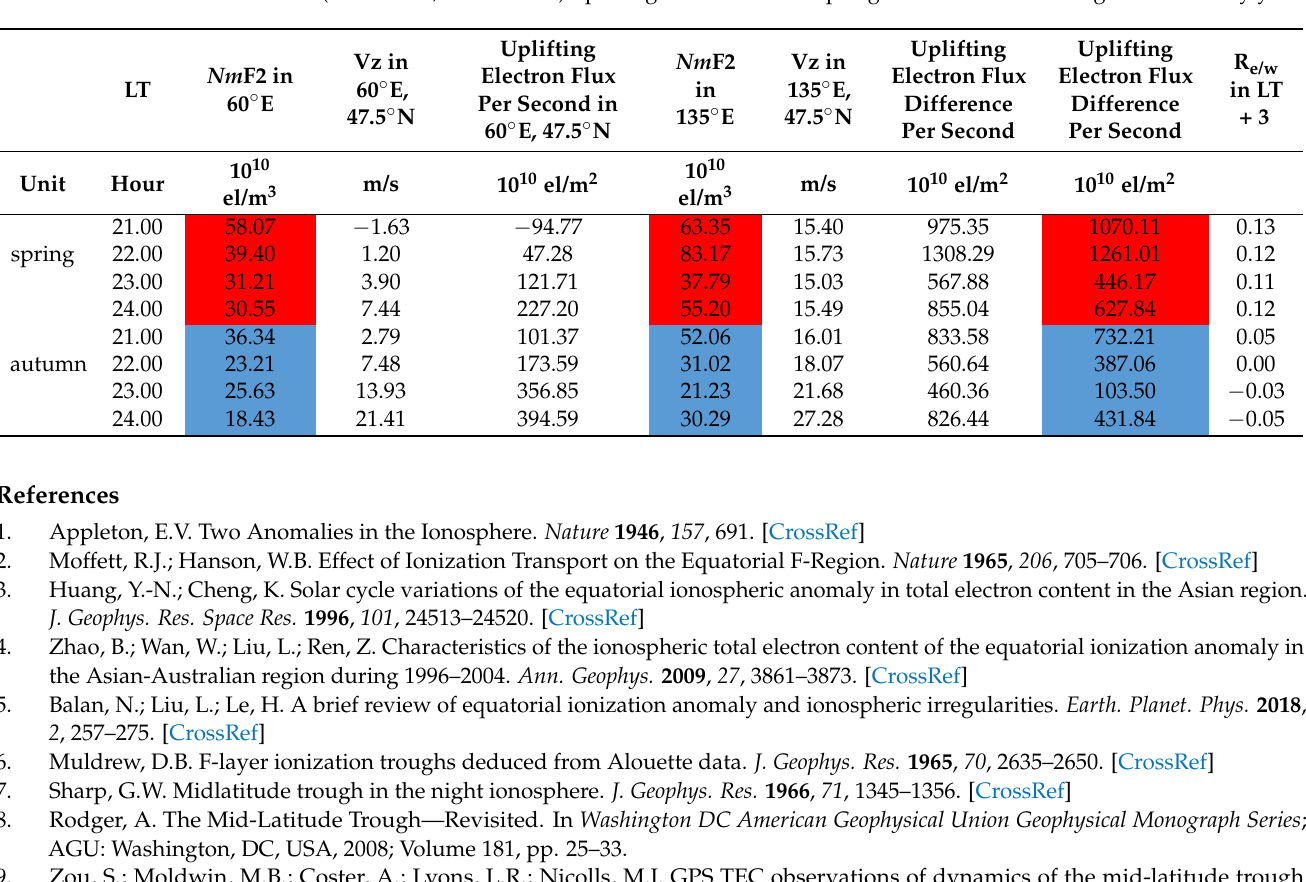
Table A2. Statistics of the difference in the east region (125 ◦ E–145 ◦ E, 45 ◦ N–50 ◦ N)-west